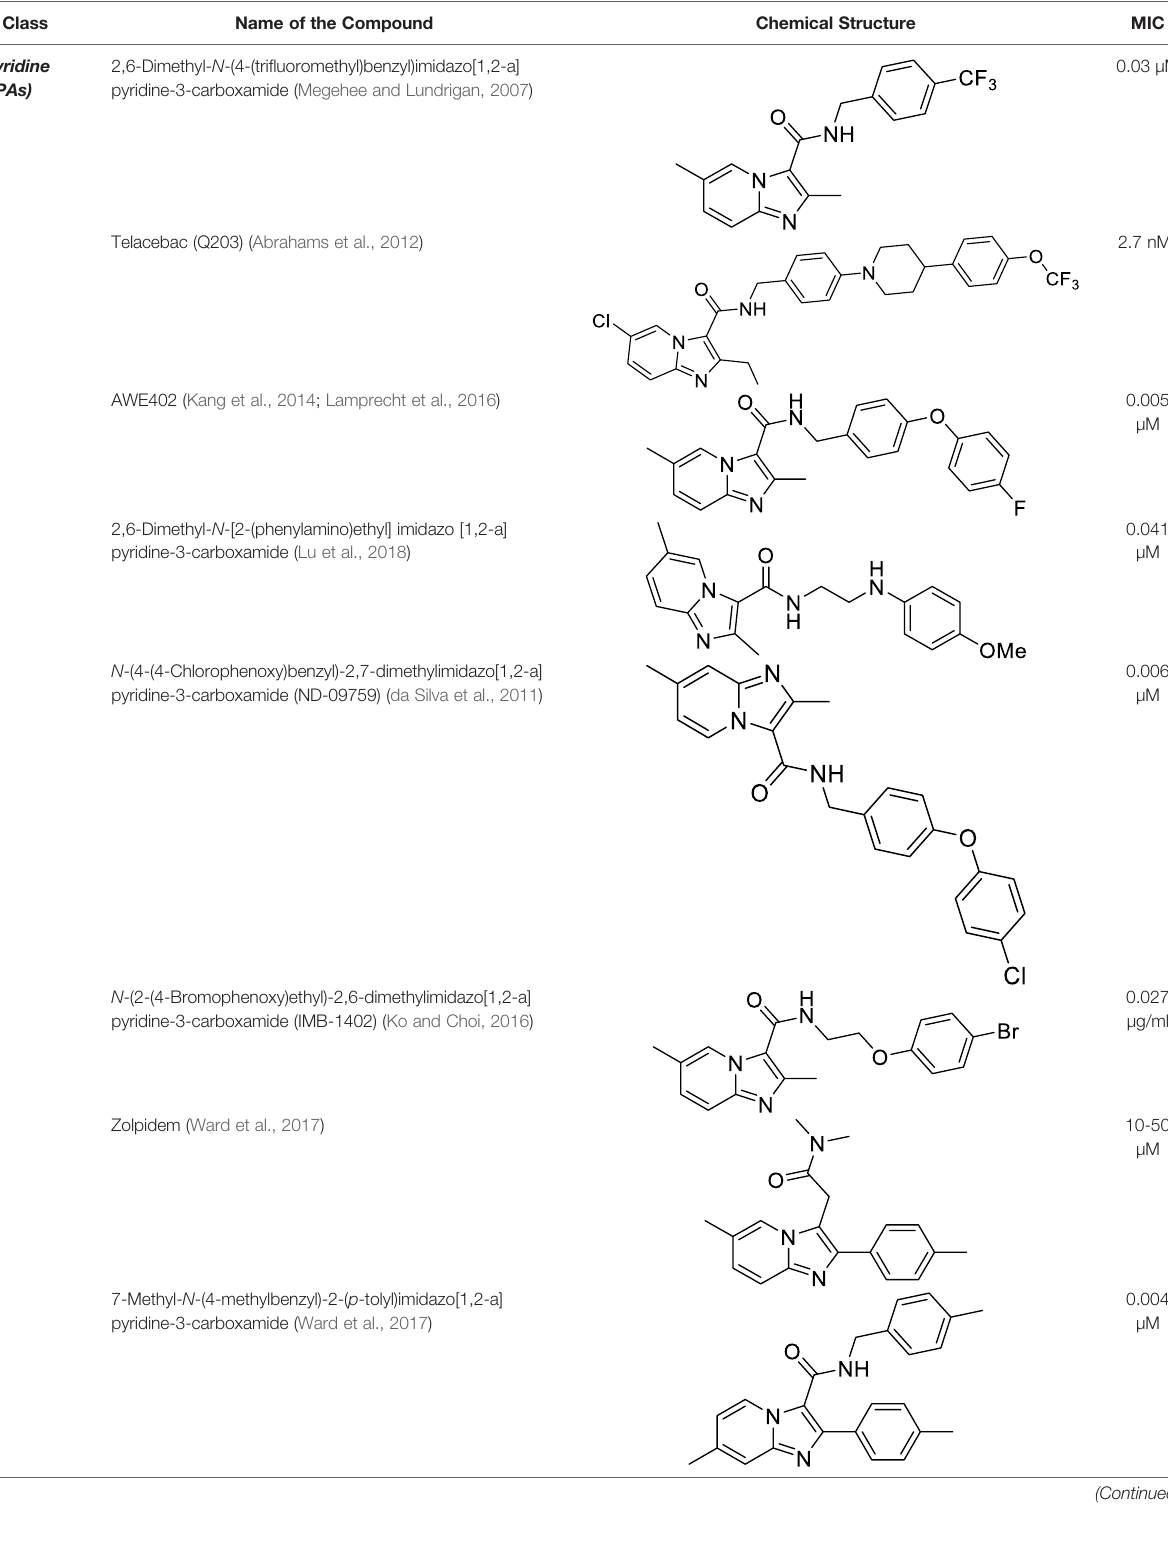
TABLE 1 | Summary of cytochrome bc 1 - aa 3 supercomplex inhibitors, their chemical structures and MIC values. Number in the parentheses denotes the references. Chemical